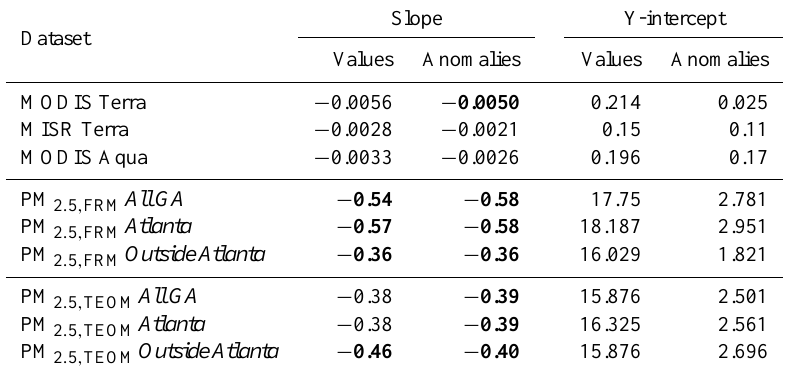
Table 1. Linear regression coefficients for satellite and PM 2 . 5 datasets. Significance for α = 0 . 5 is denoted in bold. Intercept values are